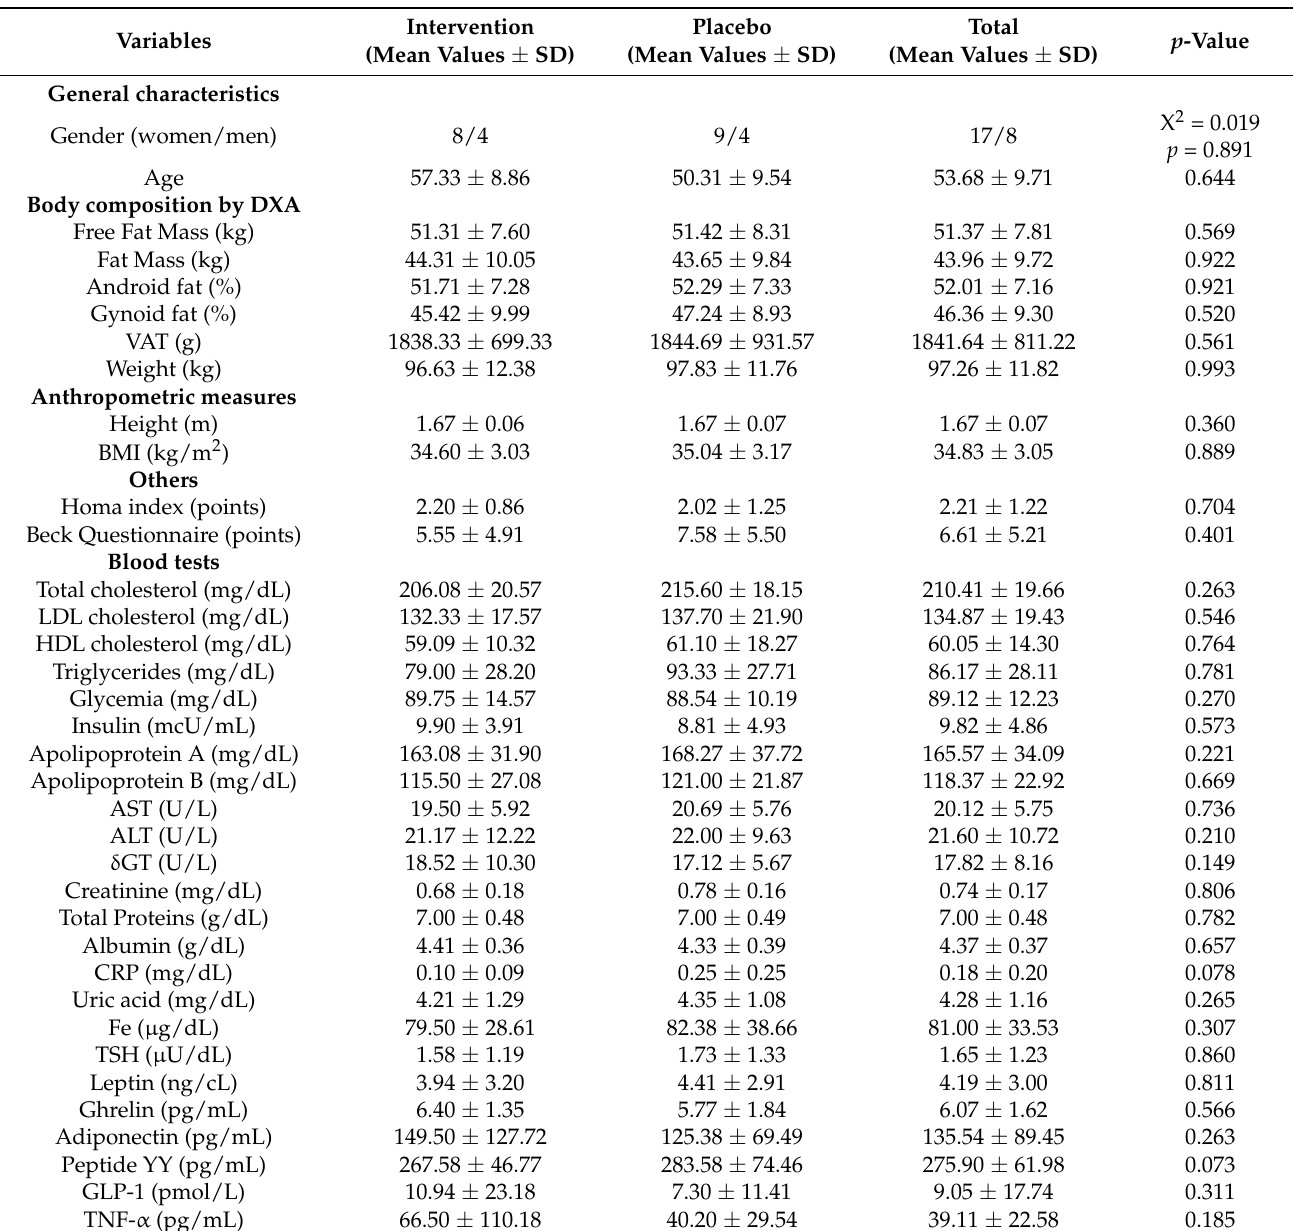
Table 1. Baseline descriptive characteristics of